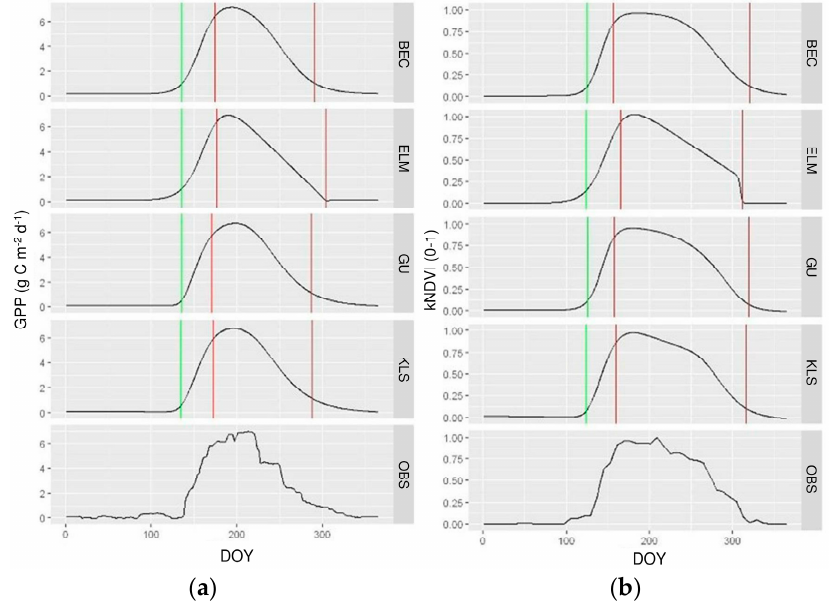
Figure 3. Example of SOS, POS and EOS extraction from GPP ( a ) and kNDVI ( b ) patterns of the Torgnon site (year 2017), with different fitting models: Becker (BEC), Elmore (ELM), Gu (GU), Klosterman (KLS)) and GU extraction. OBS represents the raw values of GPP and kNDVI. Vertical bars represent estimated SOS (green), POS (red) and EOS (dark red).